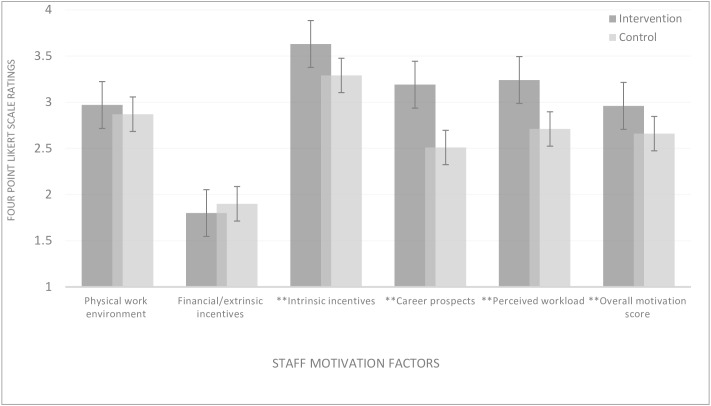
Workplace motivating factors in treatment and control facilities.Source: WOTRO-COHEiSION Ghana Project (2014); **p<0.0001 (two tailed test of hypothesis using t-test). Note1: Mean testing was based on pooled baseline and follow-up responses in 2012 and 2014 respectively. Means were derived from a four-point Likert scale from 1 = “Very disappointing” to 4 = “Very satisfactory”. High summated scores per staff motivation area depict better satisfaction with work conditions and vice-versa. Note2: Extrinsic motivation is derived from financial and material work conditions of a job (e.g. salary increment, promotion, accommodation etc.); Intrinsic motivation is derived from the inner joy and satisfaction derived from a job (e.g. societal recognition and respect; appreciation shown by clients etc.).